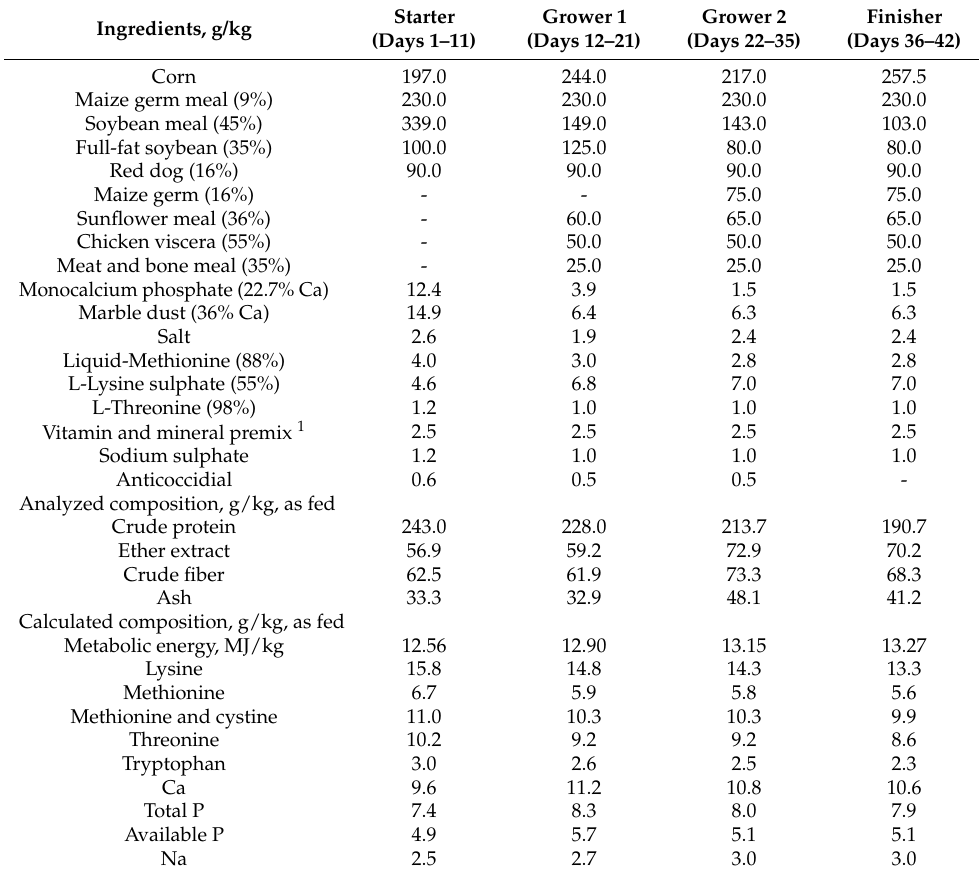
Table 1. Ingredients and nutritive values of basal